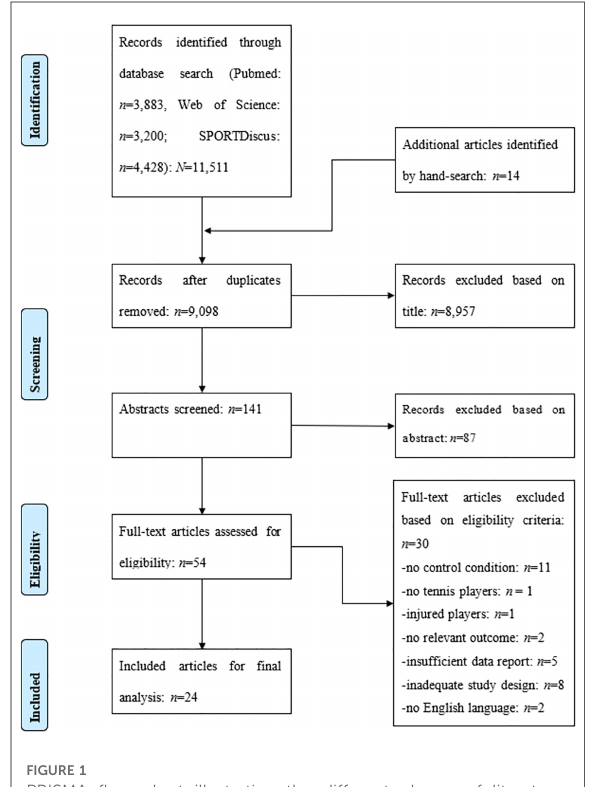
FIGURE 1 PRISMA fl ow chart illustrating the different phases of literature search, study selection, and reasons for exclusion of